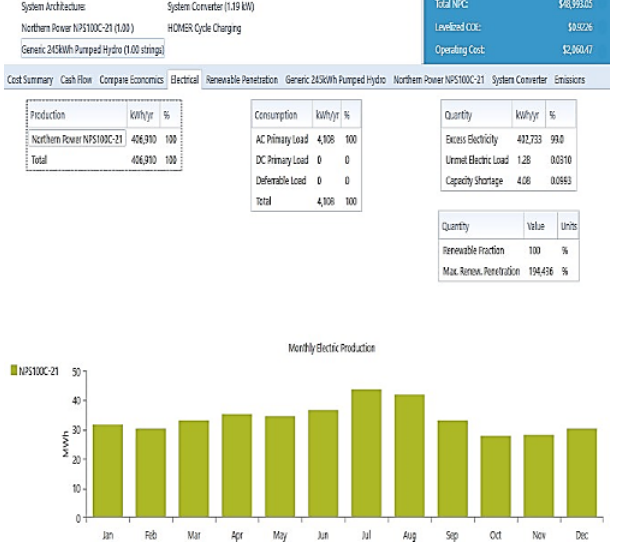
Table 5. Principal characteristics of the wind turbines Fig. 4. The results by HOMER of Northem Power NPS 21- 100KW